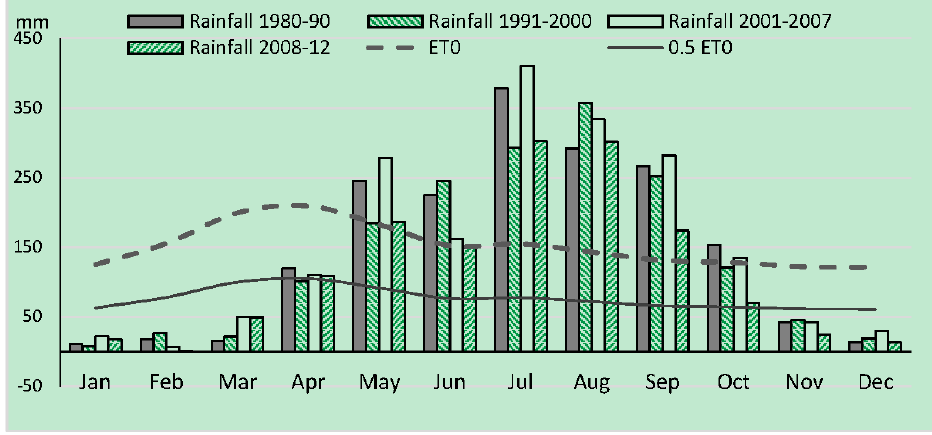
Figure 5. Length of Growing Period calculated from the data recorded at Mae Chan station.